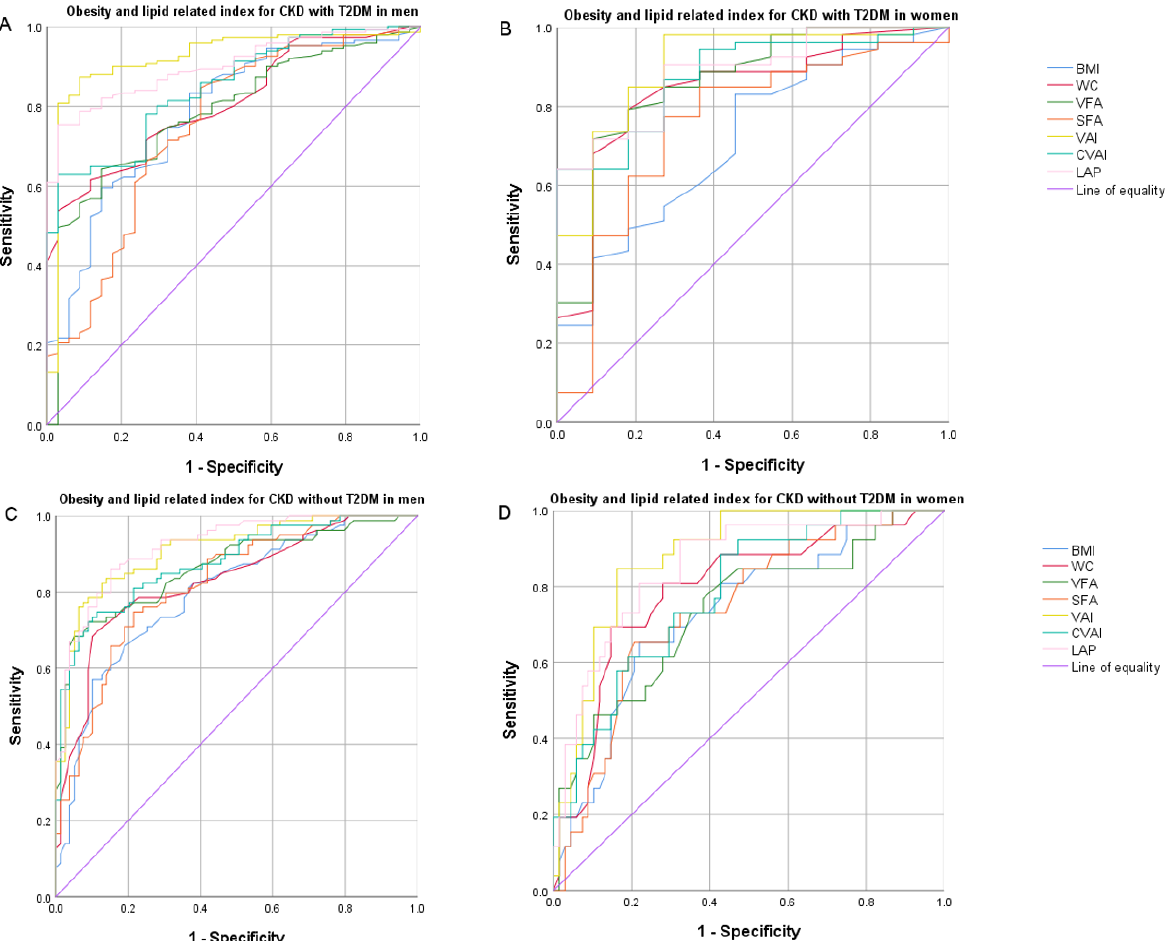
Figure 1. Comparison of the diagnostic value of BMI, WC, VFA, SFA, VAI, CVAI and LAP in predicting metabolic syndrome using Chinese (2020) criteria in CKD men and women with and without T2DM. ( A ) obesity and lipid related index for CKD with T2DM in men; ( B ) obesity and lipid related index for CKD with T2DM in women; ( C ) obesity and lipid related index for CKD with T2DM in men; ( D ) obesity and lipid related index for CKD with T2DM in women; BMI, body mass index; WC, waist circumference; VFA, visceral fat area; SFA, subcutaneous fat area; VAI, visceral adiposity index; CVAI, Chinese visceral adiposity index; LAP, lipid accumulation product; OR, odds ratio; CKD, chronic kidney disease; T2DM, Type 2 diabetes mellitus.